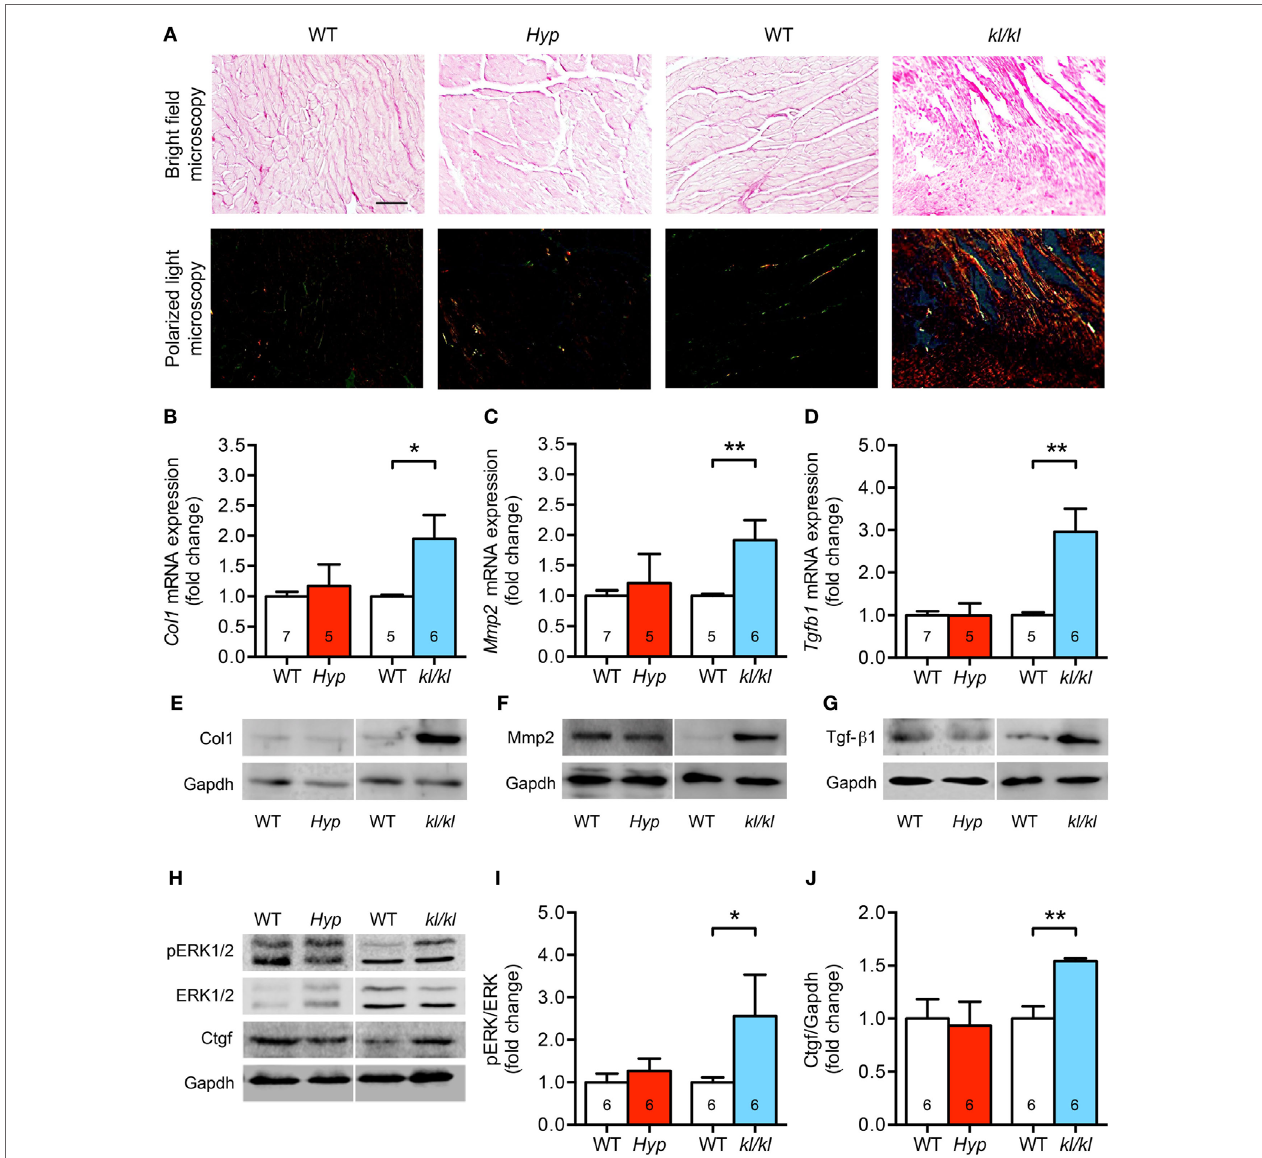
FigUre 5 | Development of cardiac fibrosis in kl/kl mice but not in Hyp mice. (a) Representative images of murine myocardial sections stained for fibrillar collagens by picrosirius red demonstrate increased accumulation of fibrillar collagens in kl/kl mice but not in Hyp mice (magnification, 20 × ; scale bar, 50 µm). (b) The mRNA levels of Col1 are higher in heart tissue of kl/kl mice and unchanged in Hyp animals. (c) Likewise, kl/kl mice show an enhanced Mmp2 mRNA expression. (D) The mRNA expression of Tgfb1 is significantly different between both mouse lines whereby it is upregulated in kl/kl animals. The protein expression of (e) Col1, (F) Mmp2, and (g) Tgf- β 1 in heart tissue lysates is markedly enhanced in kl/kl mice but not in Hyp mice. (h) ERK1/2 is only activated in kl/kl mice demonstrated by increased phosphorylated protein levels in immunoblot analysis followed by (i) densitometric quantification. (J) The levels of Ctgf protein are increased in kl/kl mice but not in Hyp mice. Values are presented as mean ± SEM; numbers in each bar graph represent the n -values used for the respective measurement; * P < 0.05, ** P <